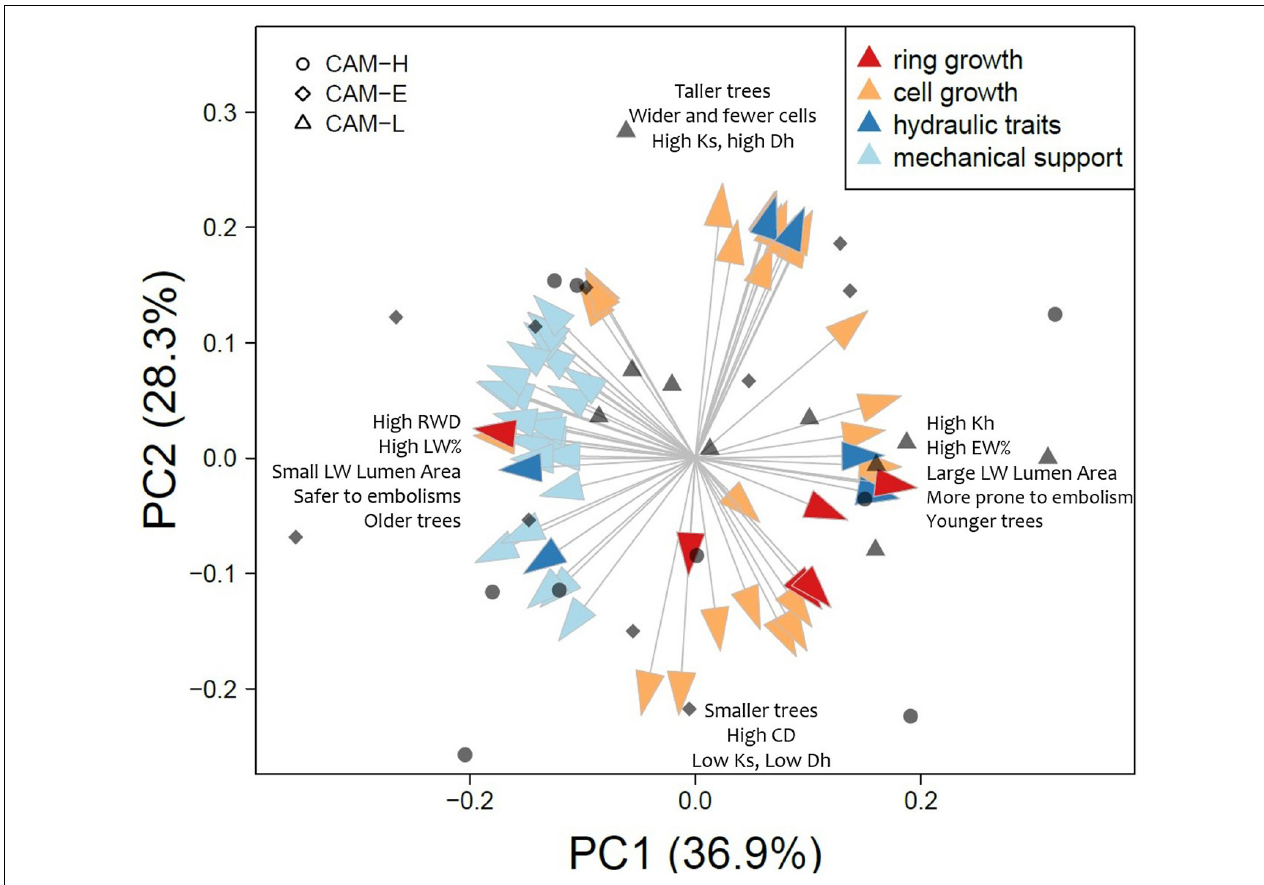
FIGURE 7 | Results of the PCA on all anatomical traits measured for the 2012 tree ring. Arrows represent the eigenvalue of each variable for the first two principal components (PC). Arrow colors indicate the function assigned to each anatomical trait according to the literature (see Table 2 ). Arrows names are written in Supplementary Figure S8 . The three symbols (circle, diamond, and triangle) correspond to individual scores on PC1 ( x -axis) and PC2 ( y -axis) from CAM-H, CAM-E, and CAM-L plots,